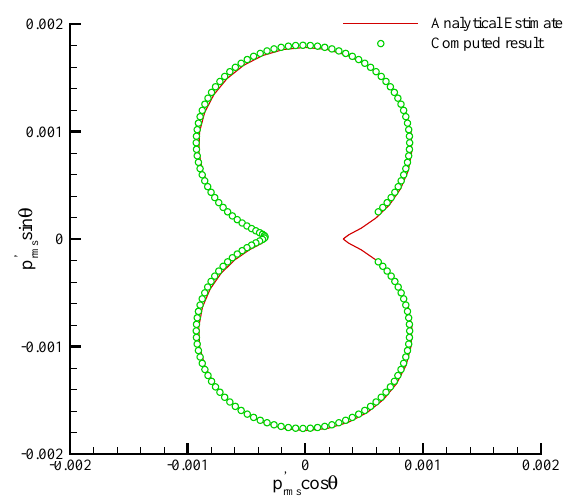
Figure 13. Comparison of computed analytical acoustic directivity for flow past a 2D cylinder. Table 1. Strouhal Number and mean force coefficients for laminar flow past a 2D